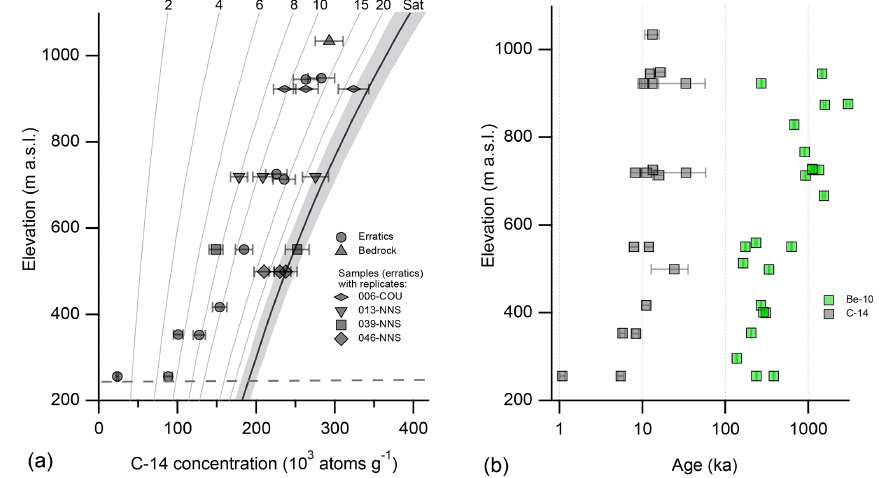
Figure 7. (a) Elevation versus in situ 14 C concentration of samples collected from the Schmidt Hills. All samples are erratics with the exception of the highest elevation sample, shown with a triangle. Samples with replicate measurements are displayed with differing symbols. (b) Schmidt Hills exposure ages from this study (in situ 14 C) and those of Balco et al. (2016) and Bentley et al. (2017) ( 10 Be). Measurements yielding infinite in situ 14 C ages are not presented on the right-hand plot.